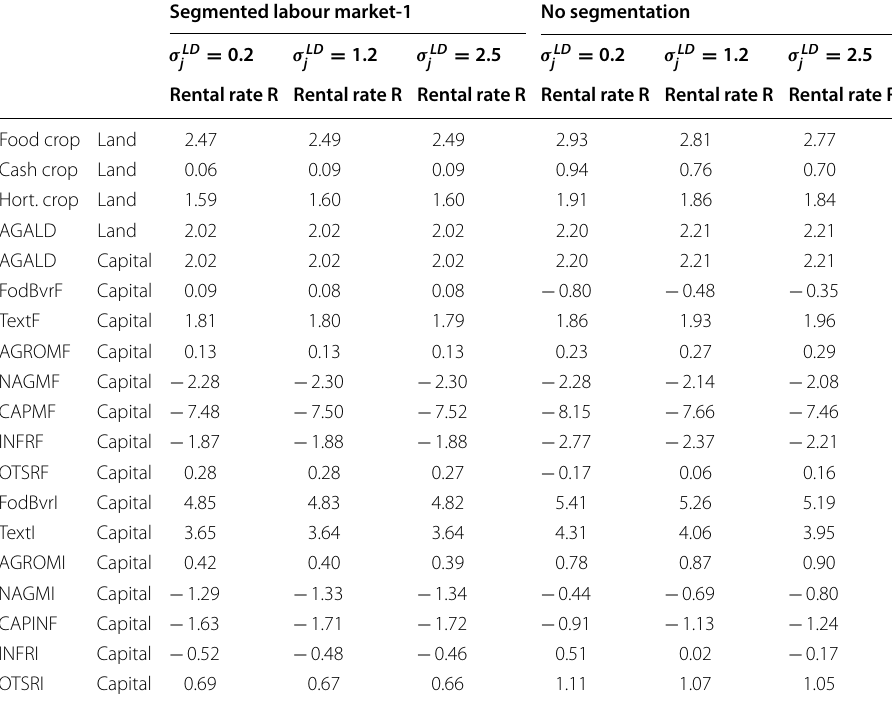
Table 5 (Scenario A1–A2:S1–S3) Change (%) in sectoral rental rate due to 50% tariff cut Segmented labour